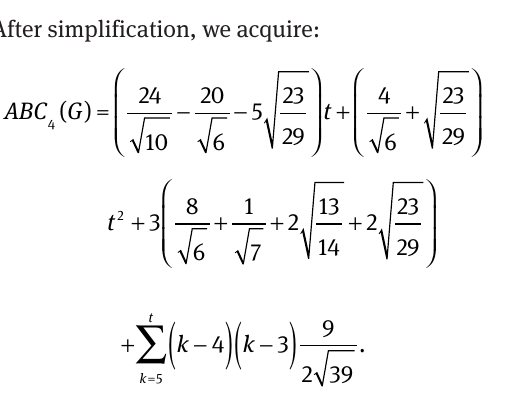
, S )-type edges, where m and n are sum m n